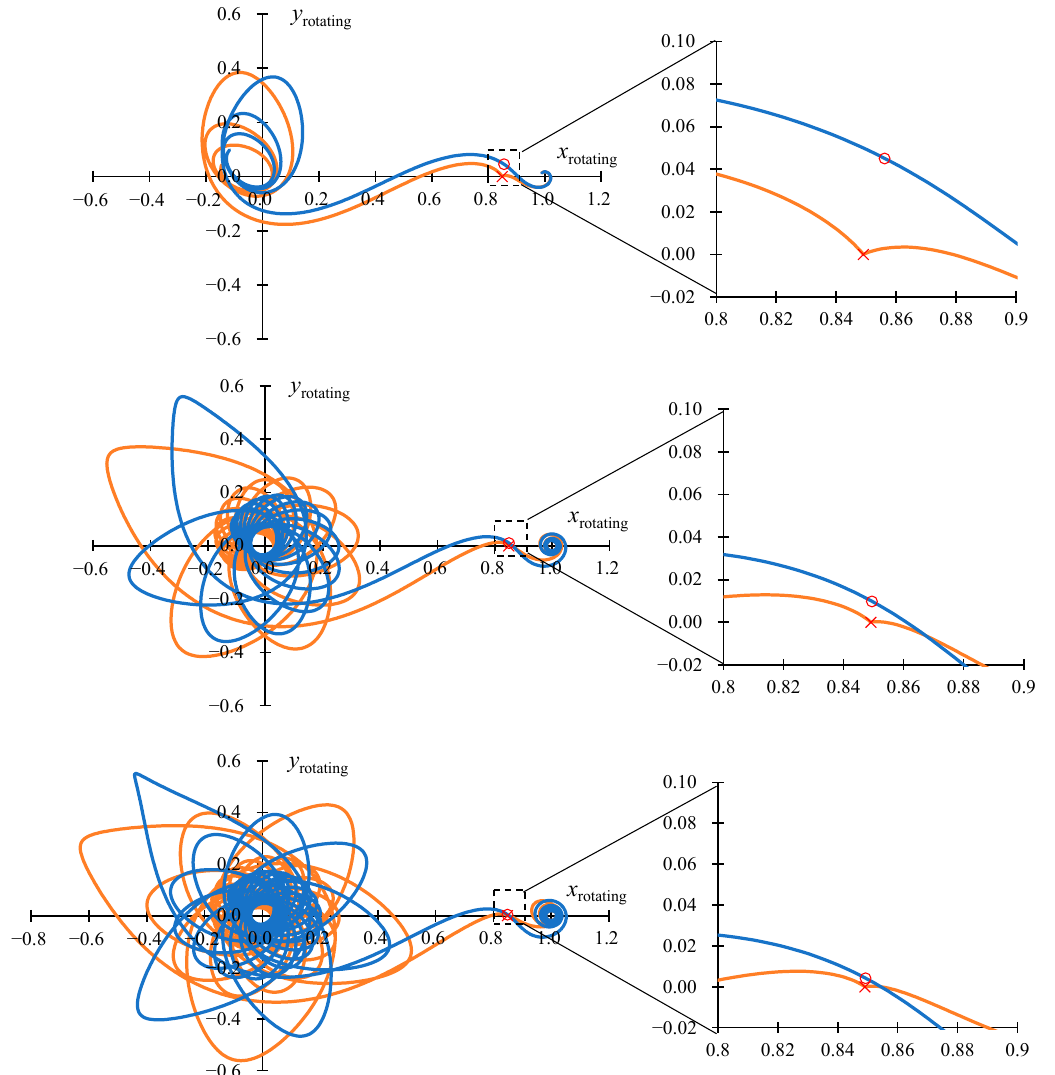
Figure 2. The projection of optimal 5-( upper row), 20-( middle row), and 35-( lower row) revolution trajectories with an optimal junction point and with an intermediate EML 1 rendezvous onto the XY plane in the rotating coordinate system.